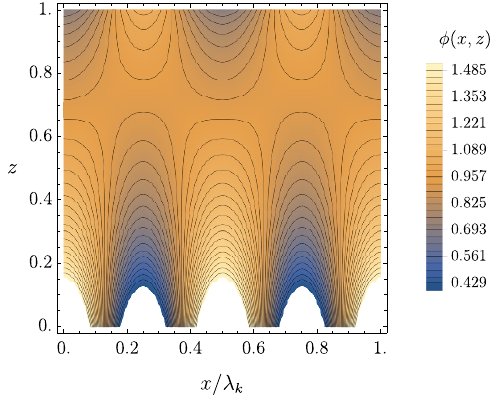
Figure 9 . Relative curvature modulation for the nonlinear solution with stripe (red curve) and without stripe (black